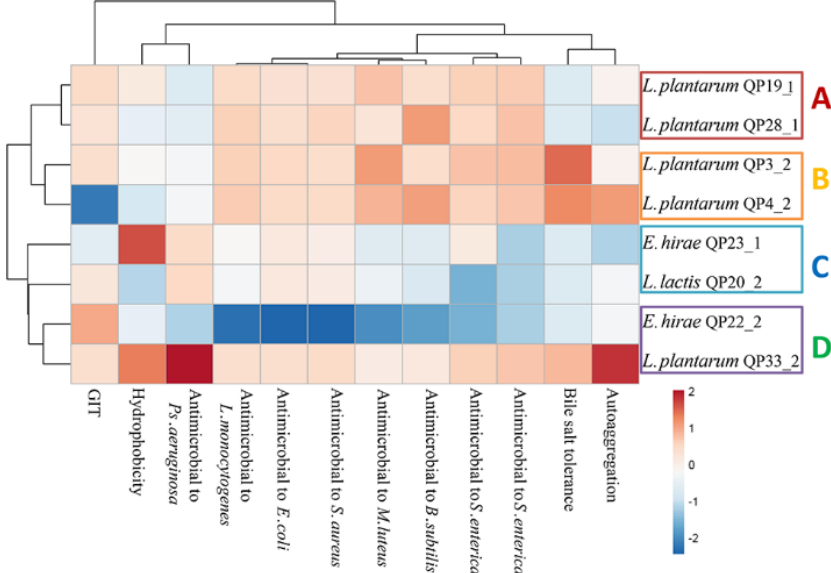
Figure 3. The heat map of LAB phenotypes, including bile salt tolerance, gastrointestinal tract (GIT), hydrophobicity, auto-aggregation, and antimicrobial to E . coli , M . luteus , S . aureus , Ps . Aeruginosa , L. monocytogenes , B . subtilis , and S . enterica .